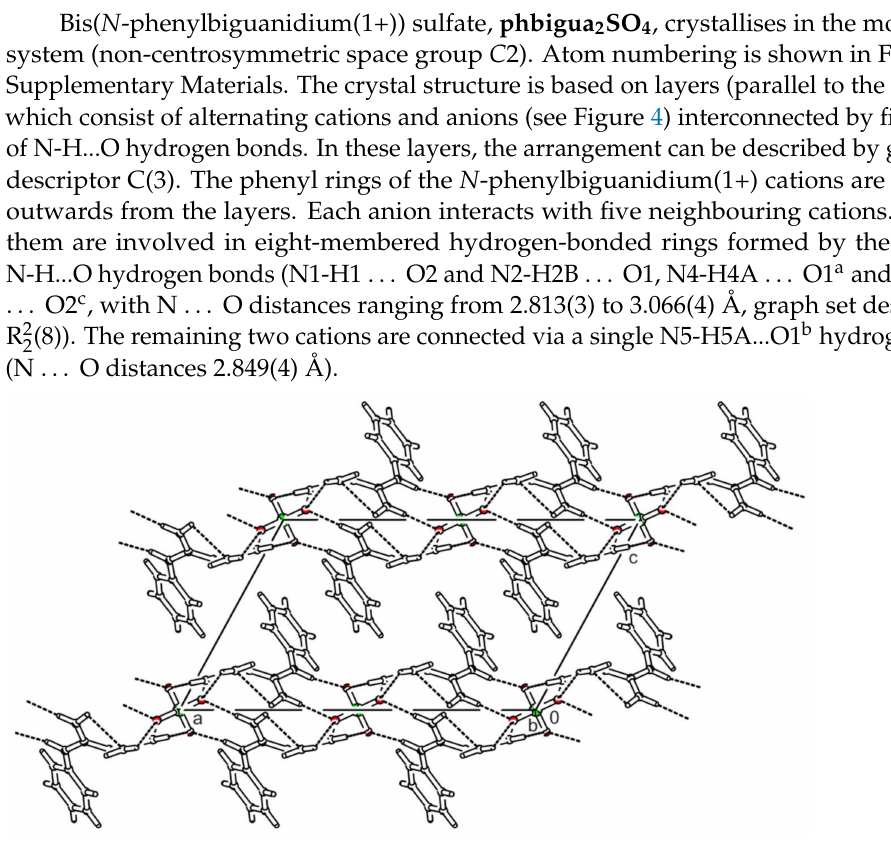
Figure 4. Packing scheme of phbigua 2 SO 4 (view along the b axis direction); dashed lines indicate hydrogen bonds, solid lines indicate unit